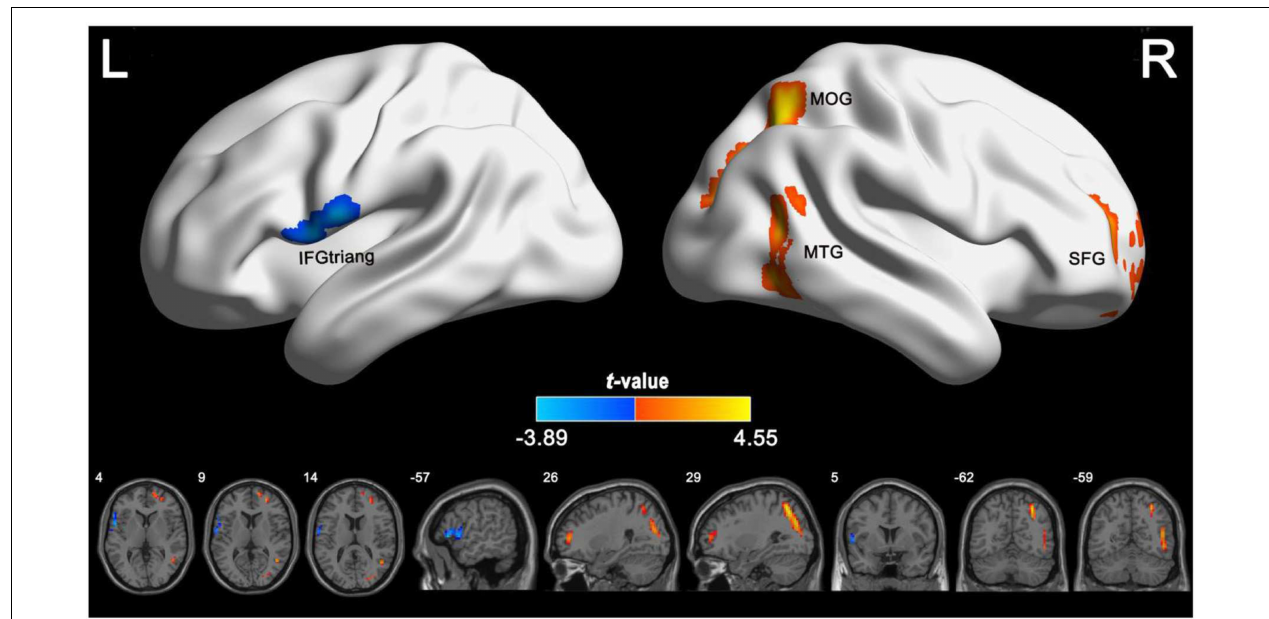
FIGURE 2 | Group differences in CBF between IGE patients and healthy controls. The independent two-sample t test was conducted between the IGE group and the healthy control group. All results were corrected for multiple comparisons (GRF-corrected, P < 0.05). The cold colors denote significantly decreased CBF in the IGE patients. The warm colors denote significantly increased CBF in the IGE patients. CBF, cerebral blood flow; GRF, Gaussian random field; IGE, idiopathic generalized epilepsy.